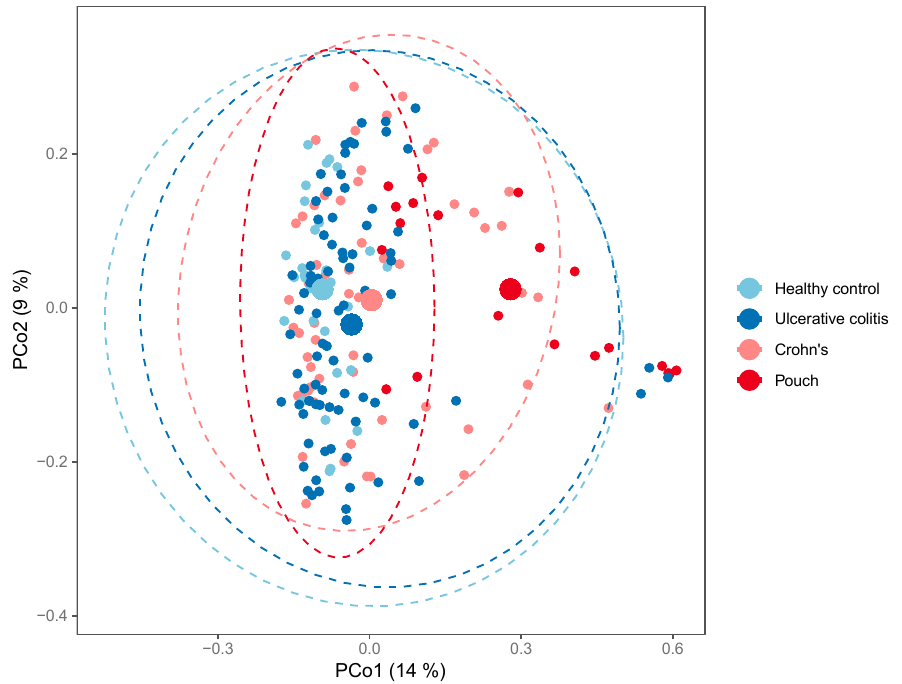
Figure 5. PCoA plot of generalized UniFrac distances by patient group; Inflammatory Bowel Disease (Crohn’s disease, N = 58 and Ulcerative colitis, N = 82), controls, N = 30, and in patients with a pouch, N = 20. The small dots are samples, while the big dots are centroids of their respective groups.